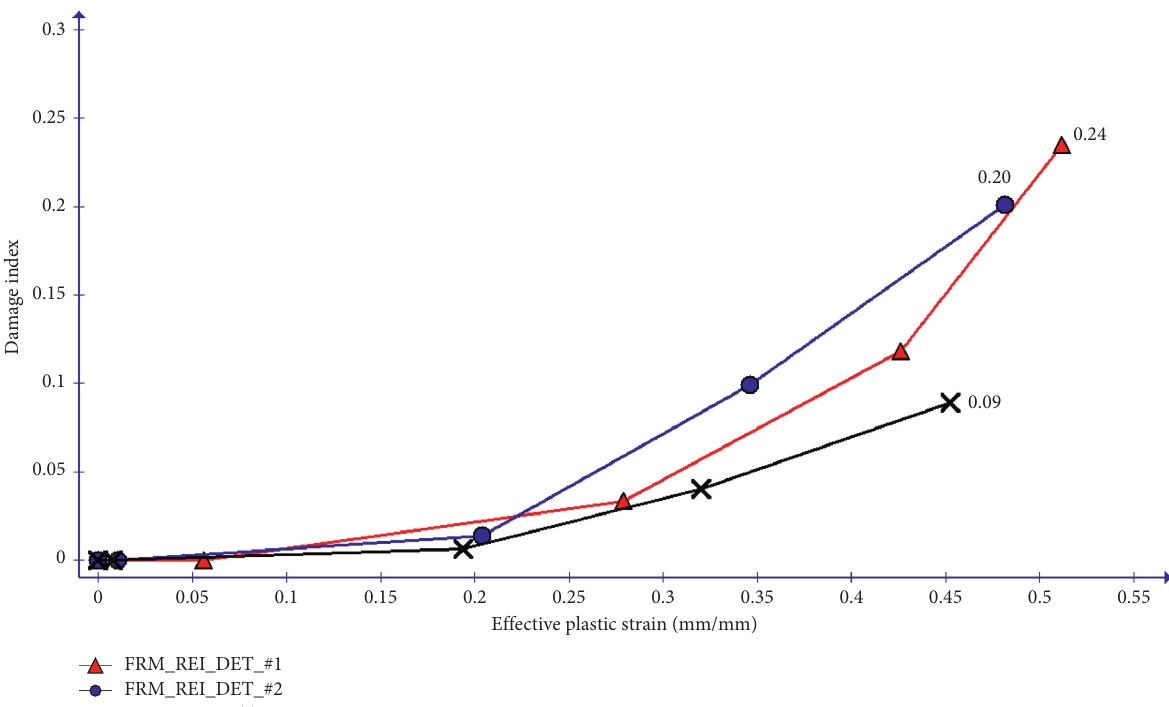
Figure 20: Column damage index vs. effective plastic strain plot for 46kg TNT explosive located at 2 nd story floor